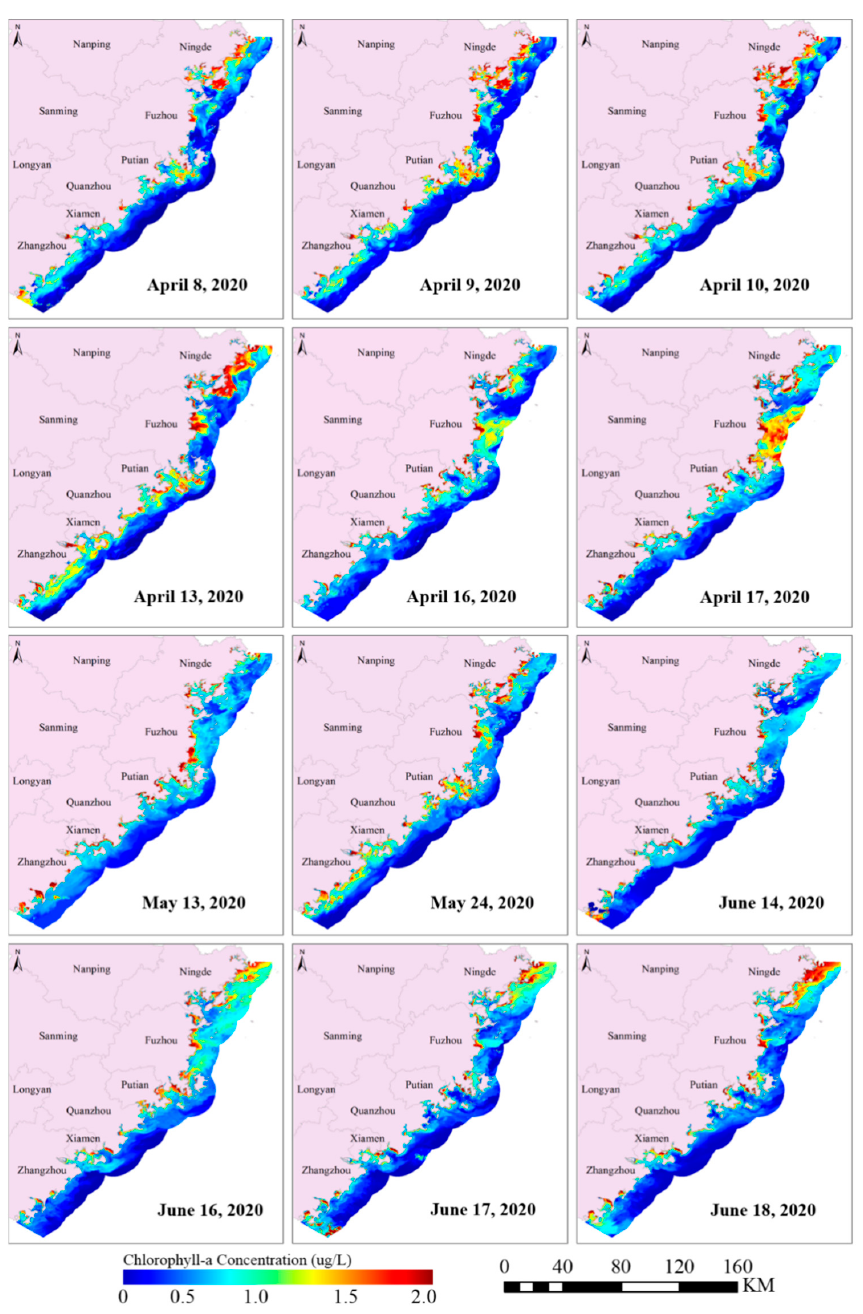
Figure 4. The estimated chl-a concentration and variation using the LightGBM-Case 4 model from the OLCI images of Fujian’s coastal waters in April to June 2020.